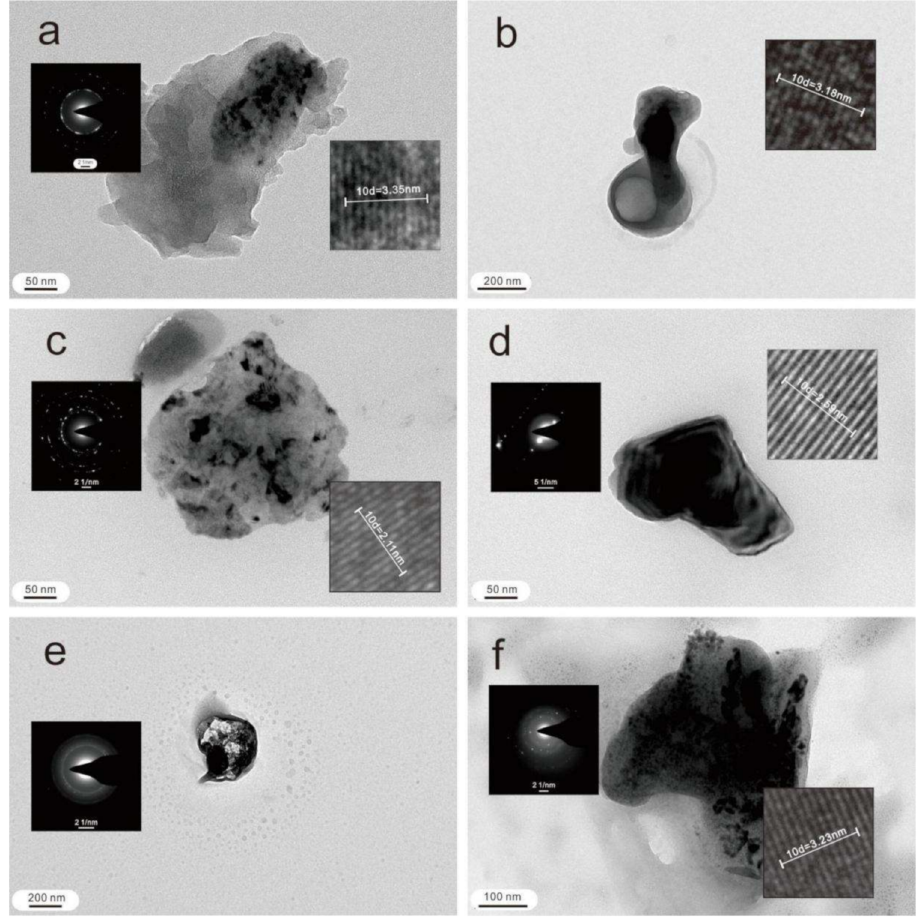
Figure 8. TEM photomicrographs of particles or aggregations in the soil. ( a ) TEM image, SAED pattern and HRTEM image of an Fe-, Mn- and Cu-bearing particle (ID14). ( b ) TEM image and HRTEM image of a Cu-bearing aggregation (ID15). ( c ) TEM image, SAED pattern and HRTEM image of a Cu- and Sn-bearing particle (ID16). ( d ) TEM image, SAED pattern and HRTEM image of a Zn-bearing particle (ID17). ( e ) TEM image and SAED pattern of a Pb- and Zn-bearing particle (ID18). ( f ) TEM image, SAED pattern and HRTEM image of a Cu-, Zn-, Bi- and Mo-bearing particle